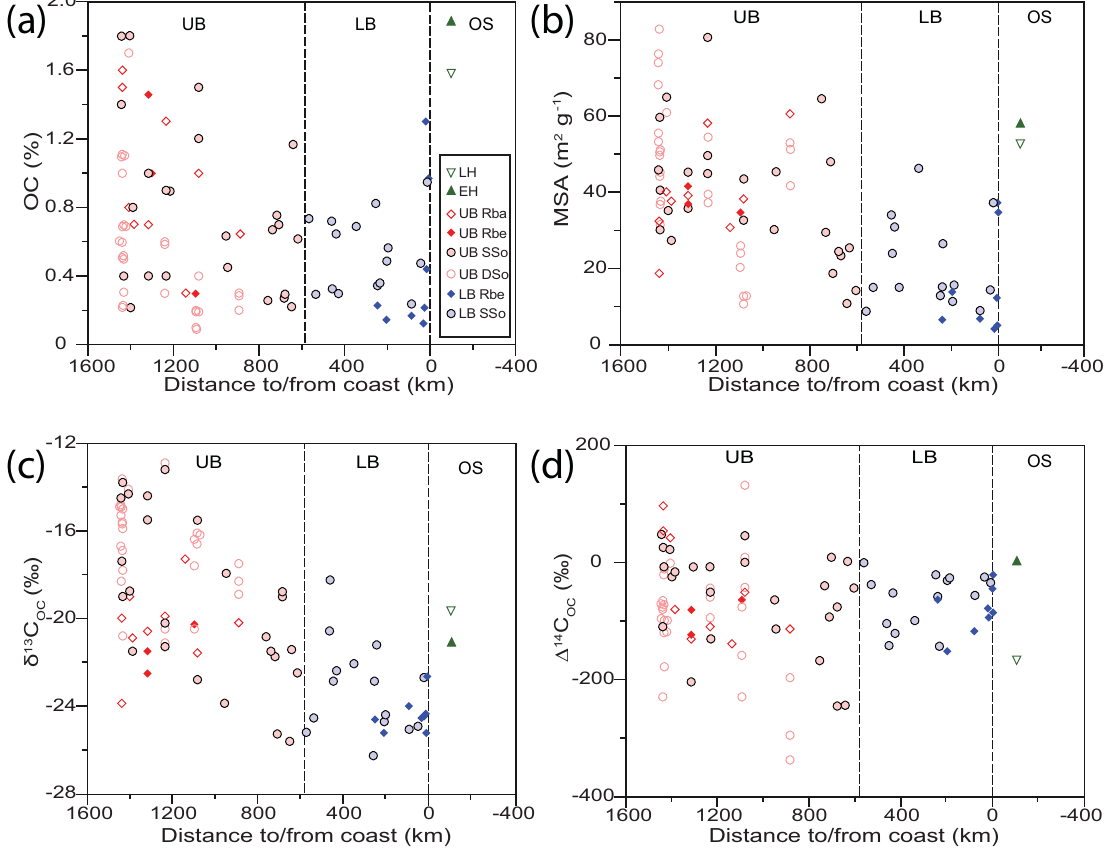
Figure 3. (a) Total organic carbon (OC; %). (b) Mineral surface area (MSA) (m 2 g − 1 ). (c) Bulk OC stable carbon isotope δ 13 C OC (‰). (d) Bulk OC radiocarbon contents ( (cid:49) 14 C OC ) (‰) in the Godavari basin and adjacent margin. Symbols key and abbreviations are as for Figs. 1 and 2. Average values of early (EH) and late Holocene (LH) sediment samples are shown.